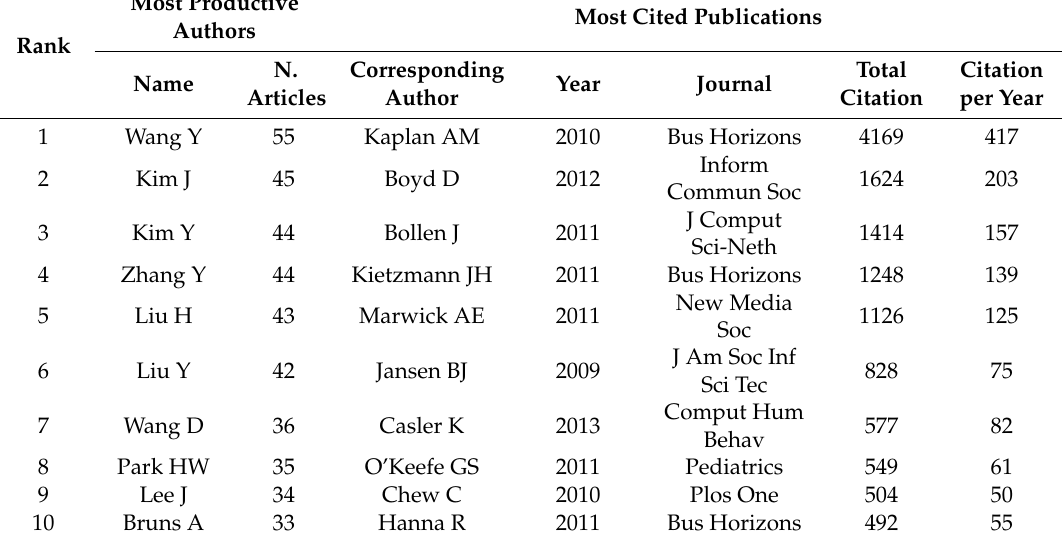
Table 3. Most productive authors and most cited publications.